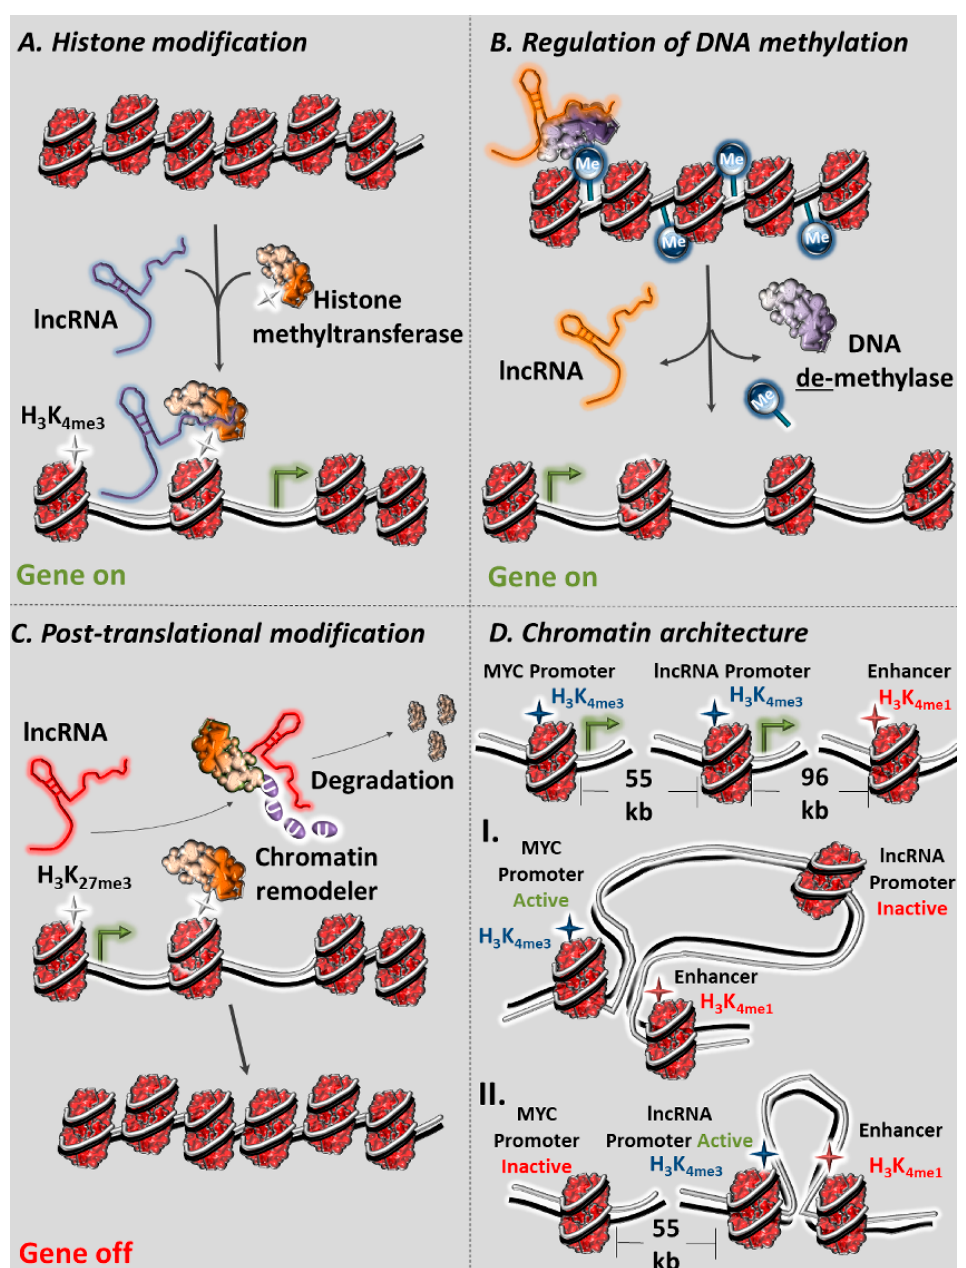
Figure 1. Molecular function of lncRNAs in chromatin regulation. ( A ) lncRNAs, such as HOTAIR, interact with chromatin remodelers such as histone methyltransferases in order to induce or suppress histone tail methylation and subsequently gene expression. ( B ) Other lncRNAs, such as TARID, regulate gene expression through demethylation of target genes. ( C ) Another implication of lncRNA function in chromatin regulation includes ANCR that regulates the post-translational stability of chromatin remodelers. ( D ) Apart from the transcript itself, regulatory elements of lncRNAs, such as the promoter of PVT1, compete with promoters of gene for interaction with common enhancers, indirectly regulating the latter in cancer.